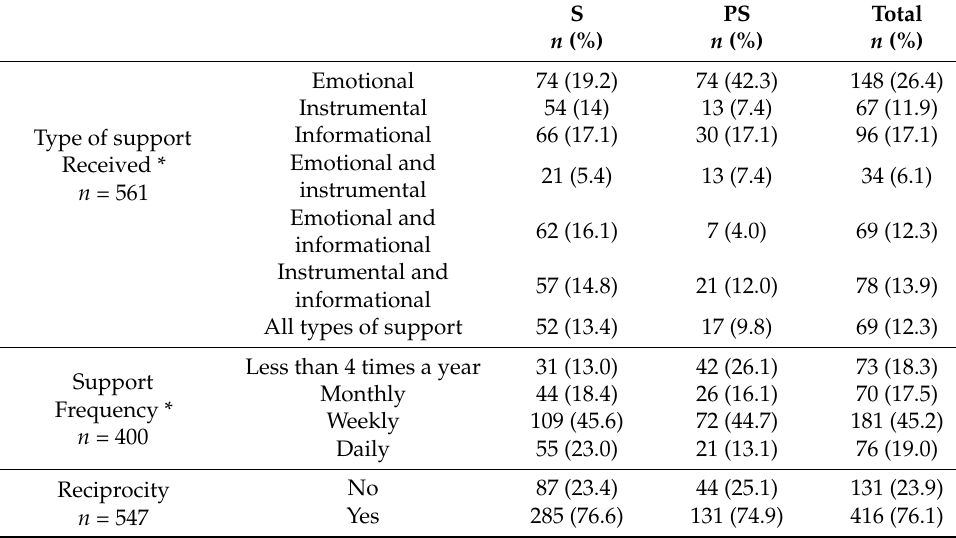
Table 5. Characteristics of social support received by